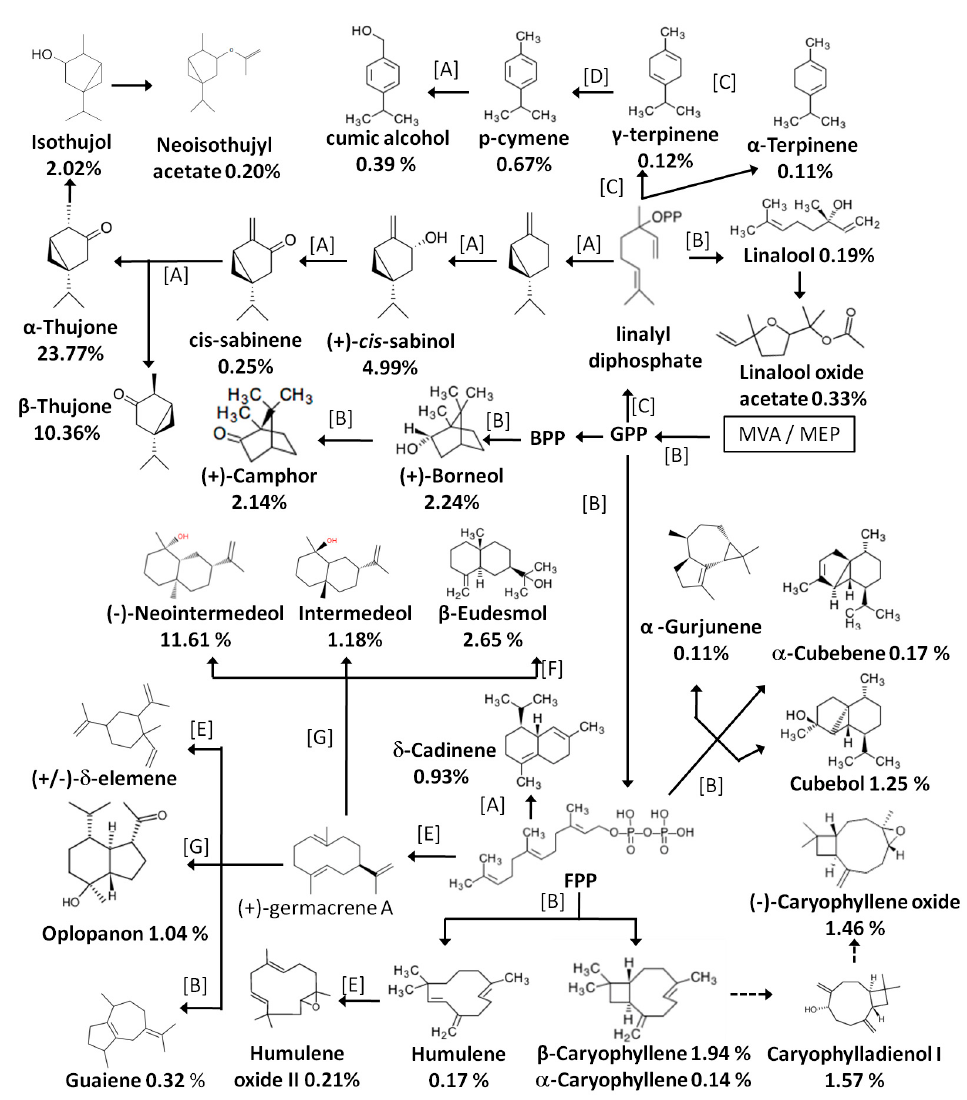
Figure 4. Summary of the biosynthetic pathway of the main monoterpenoids and sesquiterpenesin the D. indicum var. aromaticum essential oil, as identified in the present work. Notes: Dashed lines represent multiple steps; letters on arrows represent references reporting the converting steps. A: [15], B: [16], C: [17], D: [18], E: [19], F: [20], G: [21].Numbers under compound names represent the relative content of the compound in HD oil by GC-MS normalization.